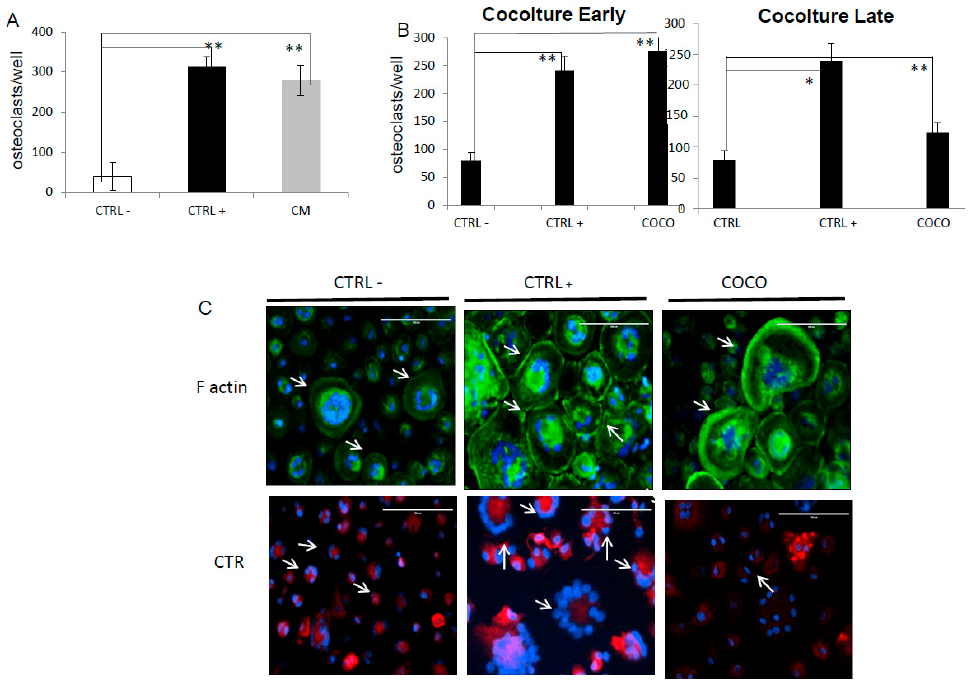
Figure 1. Co-culture optimization: ( A ) Indirect co-cocolture Conditioned medium (CM) collected by SCP2 cultures was added to complete α -MEM to obtain a CM with 20% cancer cell medium